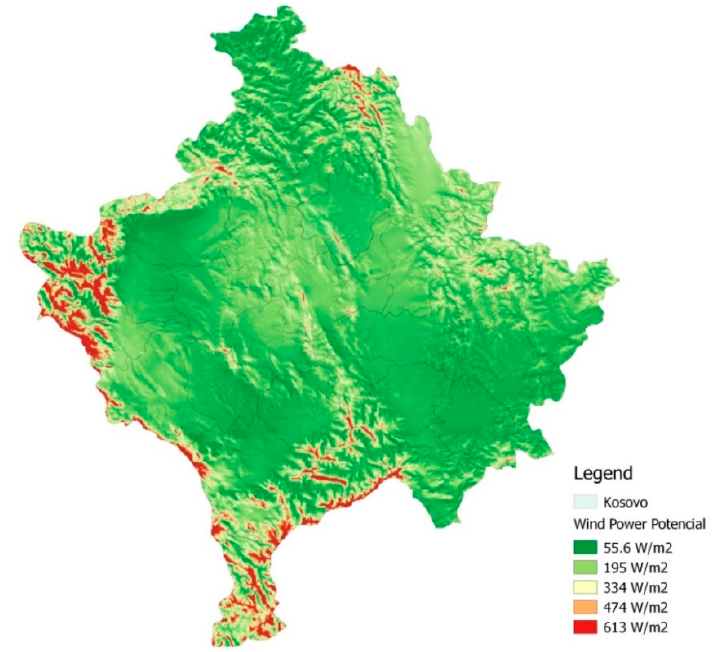
Figure 1. Wind power potential for 1 m 2 of surface rotor turbine installed at 100 altitudes above the ground level in di ff erent Kosovo area locations [16]. Table 1. Measuring location of wind speed at di ff erent zones in Kosovo